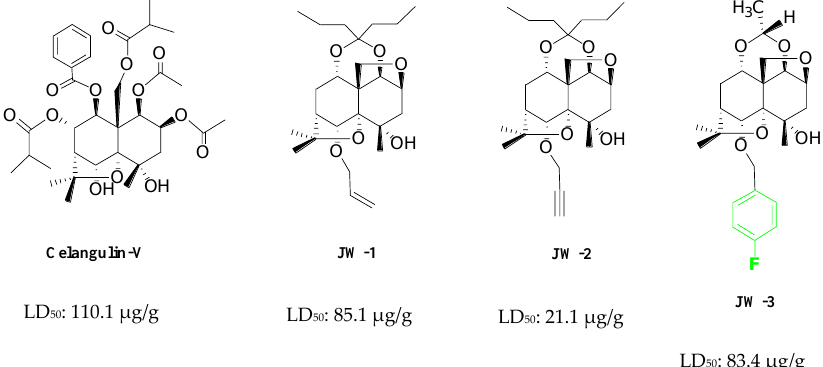
The chemical structure of Celangulin-V and some reviously reported insecticidal β -dihydroagarofuran